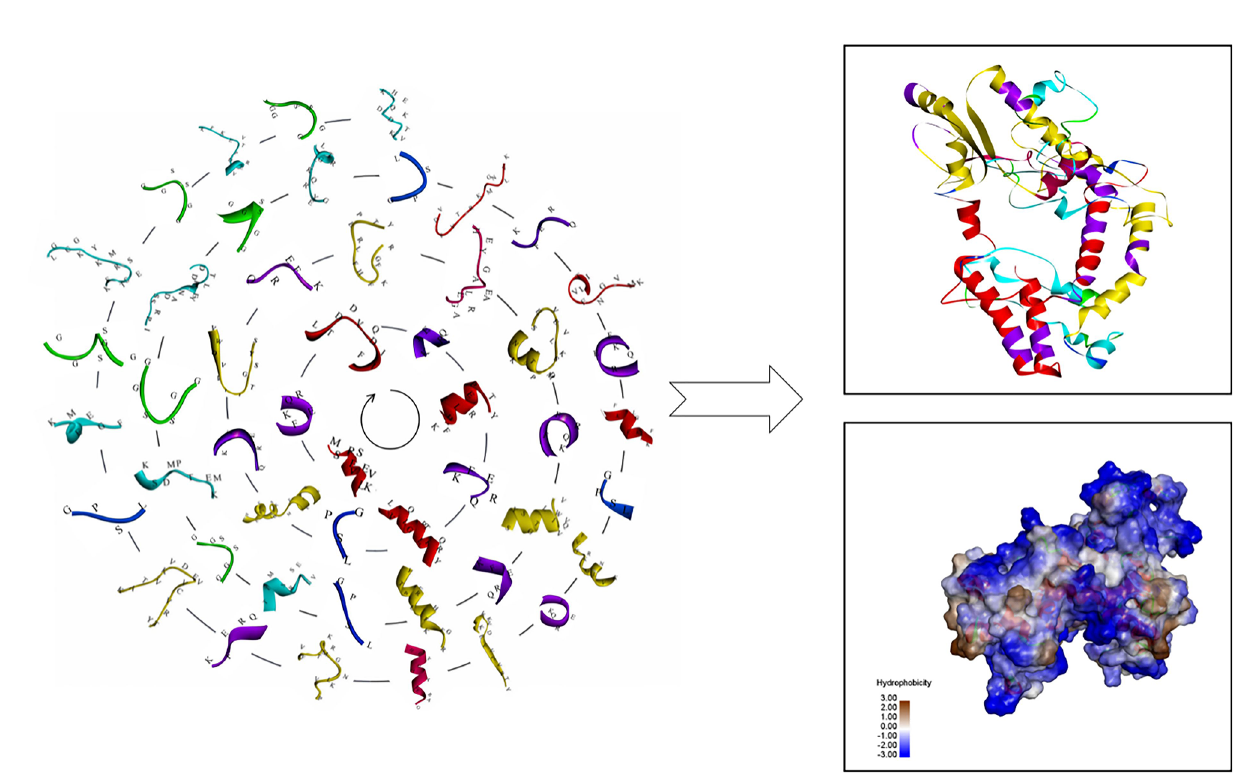
FIGURE 6 | The construction map of the vaccine model. The CD4 + TEs, CD8 + TEs and BEs of proteins EgTeg and EgFABP1 are linked separately by the speci fi c linker proteins. The linker proteins are KFERQ , HEYGAEALERAG , GPSL and GGSSGG and the corresponding amino acid sequences to each antigen peptide were written on the 3D structure of the epitopes. The parts on the right of the fi gure are the 3D structure of the vaccine, the display style are Flat ribbon and Hydrophobicity chart separately. On the Hydrophobicity chart, the bluer the color, the more hydrophilic it is and the browner the color, the more hydrophobic it is. (For understanding the reference color in remark of the fi gure clearly, please readers refer to the web version of this article).